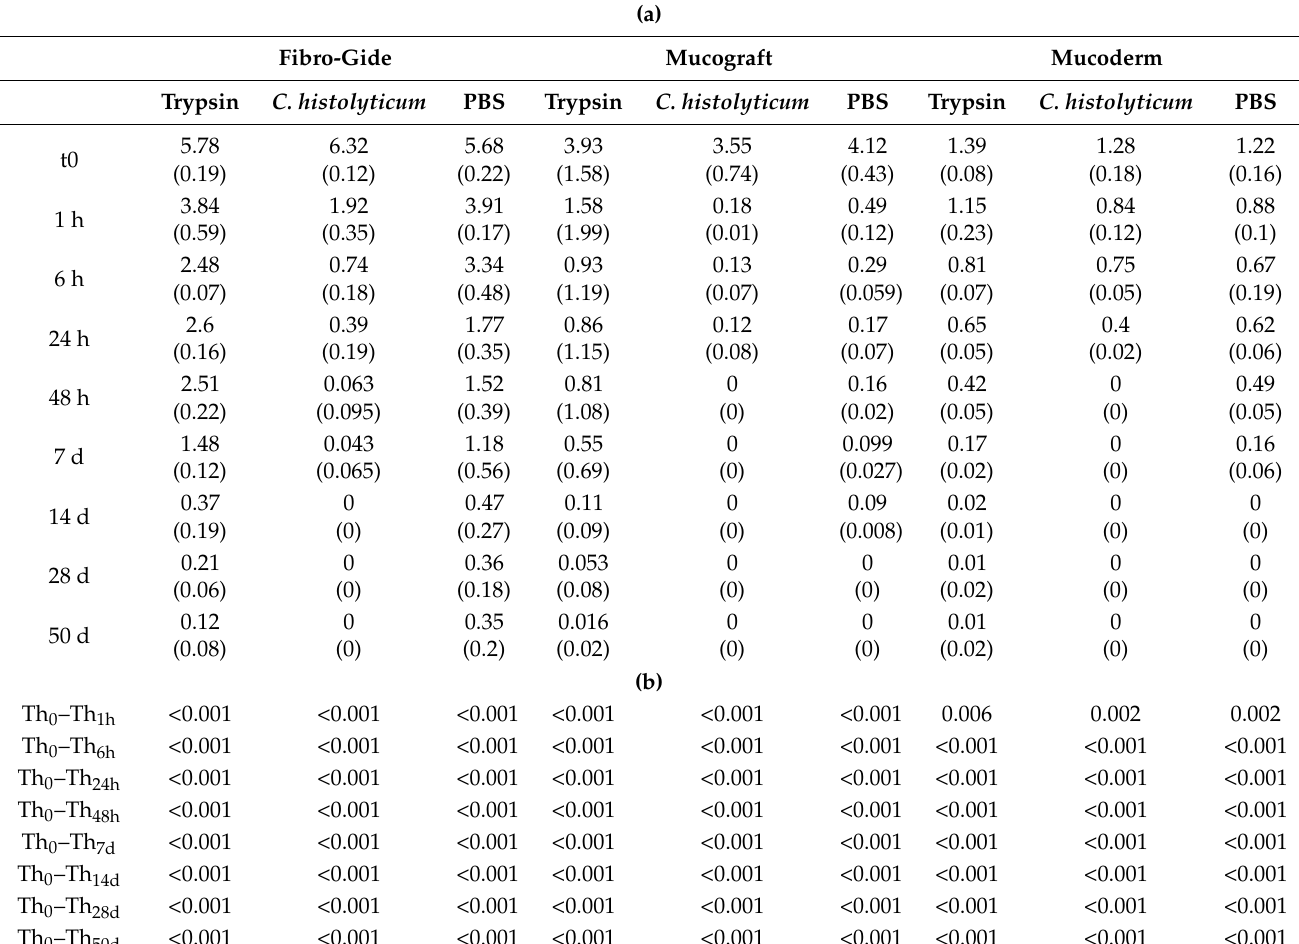
Table 2. ( a ) Thickness values (mm) of the three experimental matrices (Fibro-Gide, Mucograft and Mucoderm) after different immersion periods ranging from 1 h to 50 days in the degradation tests; PBS (hydrolytic degradation test), C. histolyticum collagenase (bacterial collagenase resistance test) and trypsin (enzyme resistance test). Values are presented as means and standard deviations. ( b ) p values obtained after pairwise comparisons between matrices’ thicknesses after different immersion times and the initial thickness (thickness at t0: Th0). Statistical significance was considered at p ≤ 0.001.